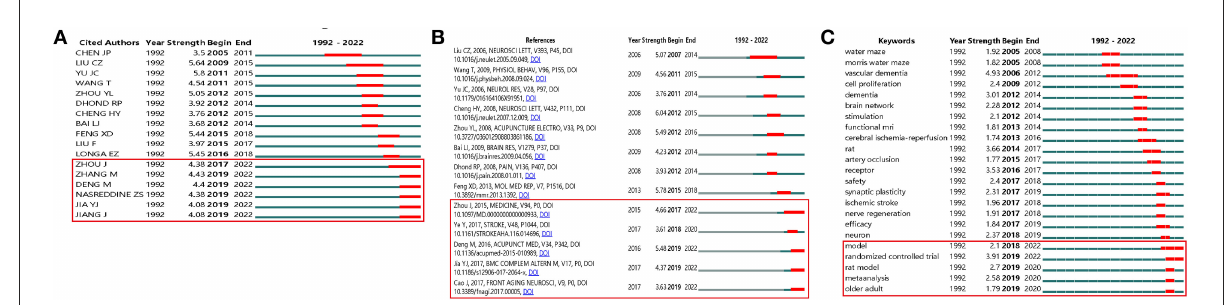
FIGURE8 The co-cited authors, co-cited references, and keyword with the strongest citation bursts. (A) The co-cited authors with the strongest citation bursts, (B) the co-cited references with the strongest citation bursts, and (C) the keyword with the strongest citation bursts. Among them, the co-cited authors, co-cited references, and keywords in the red box are the most obvious in the past 3 years, which may be the latest research hotspots.